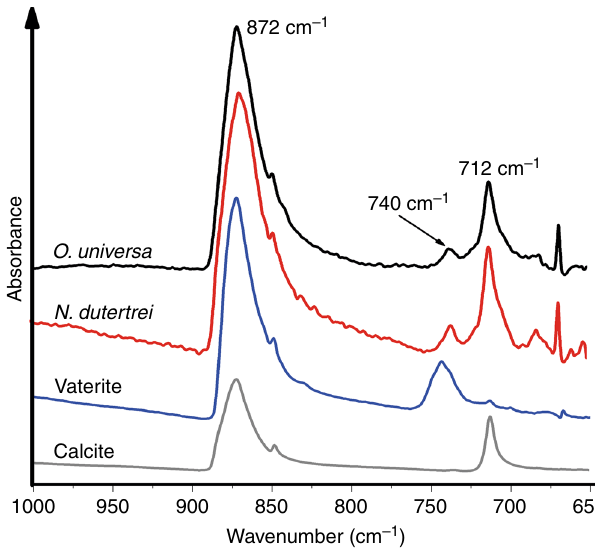
Fig. 5 Fourier transform infrared spectra of geological calcite and vateritic Herdmania momus spicules compared to O. universa and N. dutertrei shells. The absorption bands at ~740 and 712 cm − 1 are the ν 4 vibrational frequencies of in-plane bending of the carbonate ion 28 . The carbonate ion in vaterite has a higher vibrational frequency (~740 cm − 1 ) than in calcite (712 cm − 1 ) because of differences in the bonding environment of the ion, and these bands are diagnostic of the two mineral phases. The ~740 cm − 1 peak in the foraminiferal specimen is slightly offset from the vaterite peak in Herdmania momus (~743 cm − 1 ). These peaks are the same within spectral resolution of the instrument (4 cm − 1 ), although this offset could also indicate subtle differences in vaterite structure. The relative areas of these bands suggest that the foraminifera contain ca. 4.5% vaterite in O. universa and 3% in N. dutertrei (ref. 29 , see Methods). All analyses carried out